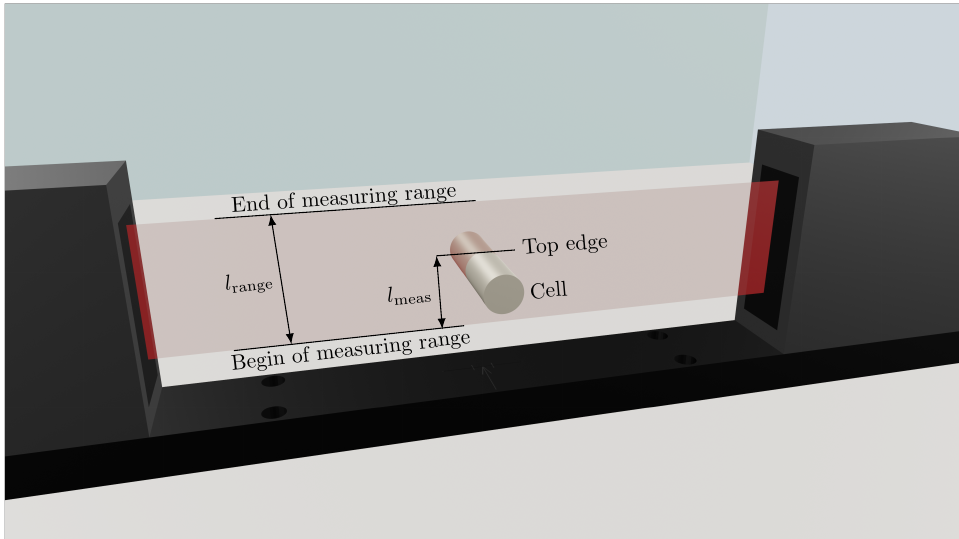
Figure 2. Schematic measurement setup with the light band micrometer from Micro-Epsilon Messtechnik GmbH & Co. KG for investigating the punctual expansion of the cylindrical Li-Ion cell (LG INR18650 M29) at the top edge of the cell located in the l range high light band marked in red. In fact, the distance between the LG INR18650 M29 and the end of the measuring range is measured ( l meas ). As the cell expands, the distance decreases and vice versa. The cell is cycled in the light band micrometer and rotated 10° after charge and discharge, until the complete circumference has been measured with a total of 36